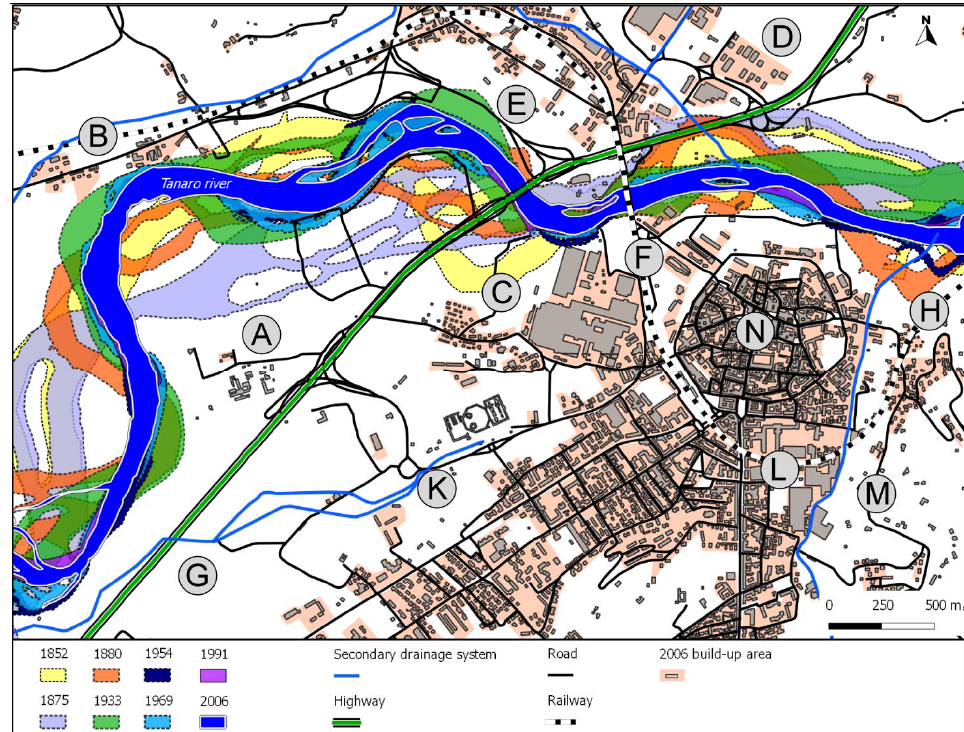
Fig. 6 - Planform changes of the Tanaro riverbed during the period 1852-2006 from historical maps. Letters in gray circles indicate Alba’s different quarters. Fig. 6. Planform changes of the Tanaro riverbed during the period 1852–2006 from historical maps. Letters in gray circles indicate Alba’s different - For the flood levels measured at the Pollenzo water gauge, a high hydrometric level does not always correspond to reports of damage. In the period between the beginning of measurement (1890) and the Second World War, 20 floods reached heights greater than 3.60 m. However, damage documentation is available for only four floods, which probably indicates that few structures and infrastructures were present in the flooded areas. For the flood of November 1962, little damage was reported, most likely because of the remedial work along the riverbed after the destruction wrought by the four major floods of 1948-1951. In contrast, damage reports exist for the floods of April 1941 and October 1942, which were characterized by modest floodwater heights. It should be noted that the documentation relates mainly to localized flooding and the disruption or destruction of bank protection. Finally, for the November 1968 and